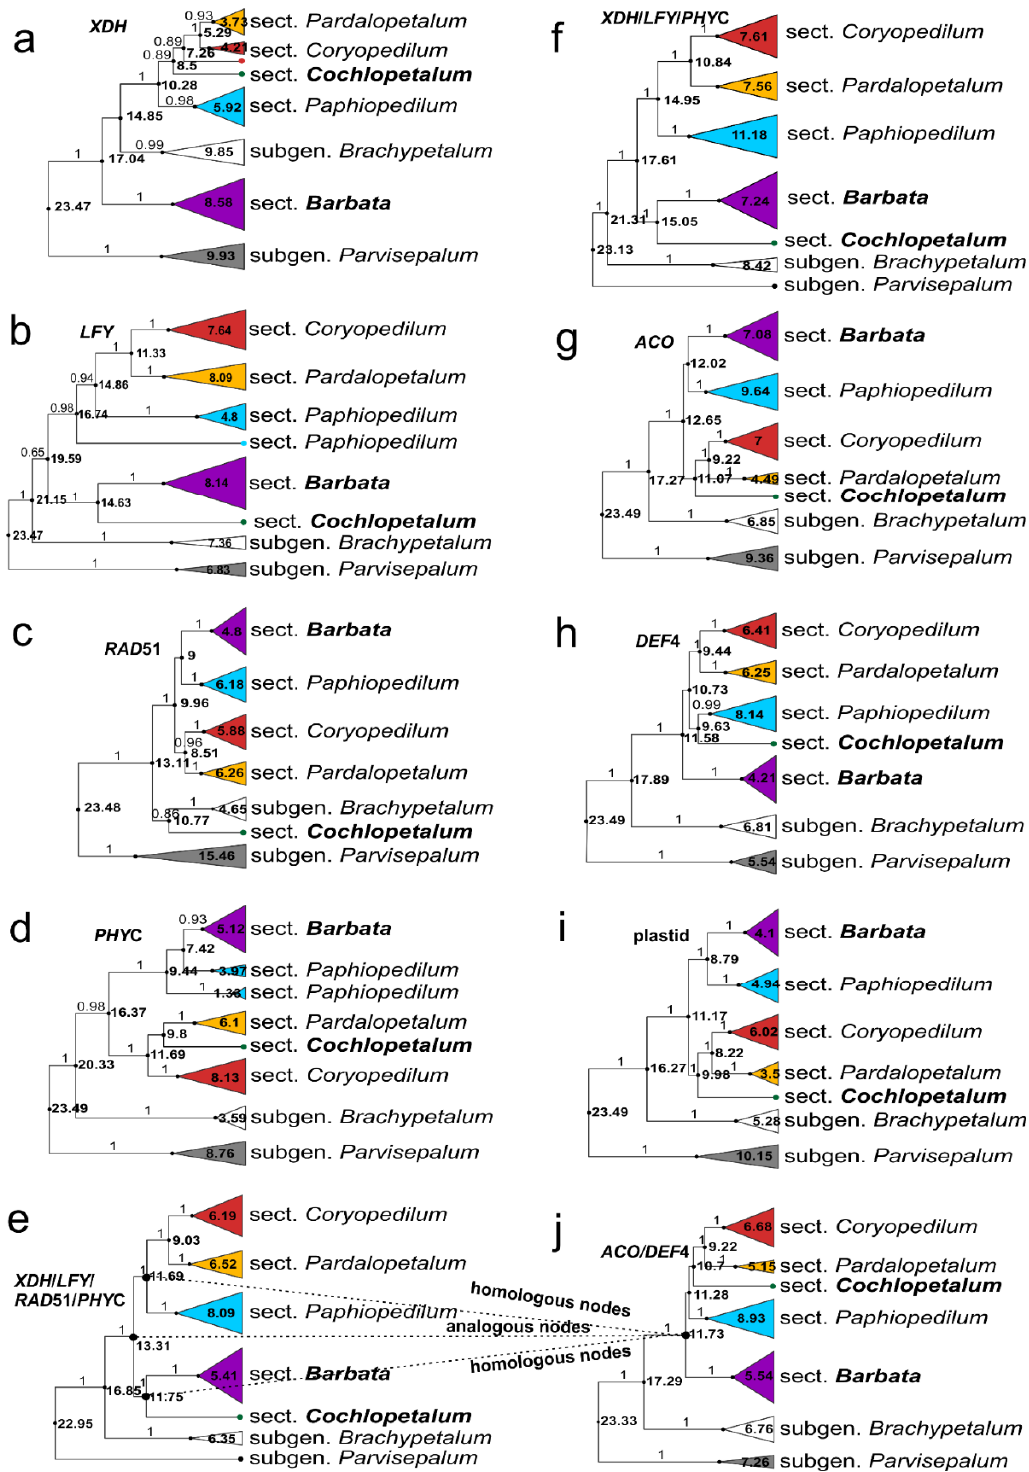
Figure 1. Time-calibrated gene trees of Paphiopedilum genus (maximum clade credibility trees) resulting from BEAST analysis of the nuclear data: ( a )— XDH ; ( b )— LFY ; ( c )— RAD51 ; ( d )— PHYC ; ( e )—combined XDH / LFY / RAD51 / PHYC ; ( f )—combined XDH / LFY / PHYC ; ( g )— ACO ; ( h )— DEF4 ; ( j )— ACO / DEF4 ; and ( i )—plastid combined data.